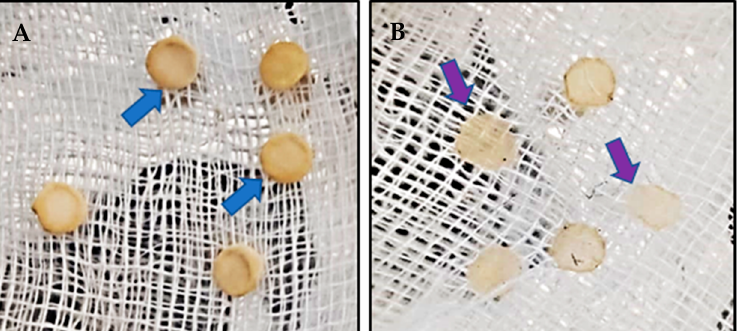
Figure 6. Phytophthora cinnamomi mycelia dried (after 24 h at 65 °C) on PDA plugs (5 mm diam.) grown in potato dextrose liquid medium (50 mL) for 48 h in shaking (180 rpm) at 25 °C. Some of n plugs are shown as representative of the assay. A: Control treatment (only with bu ff er solution), and B: Cast_Gnk2-like pure protein treatment (250 µL and 0.5 mg/mL).